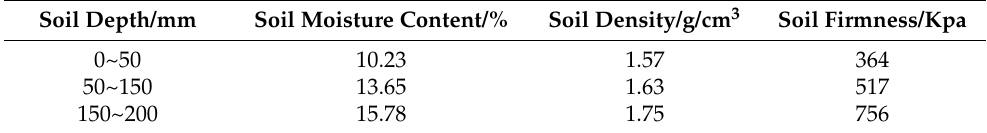
Figure 13. Field trial conditions measurement. ( a ) Measurement of planting pattern of Cyperus esculentus ; ( b ) planting depth measurement of Cyperus esculentus . Table 4. Soil parameter